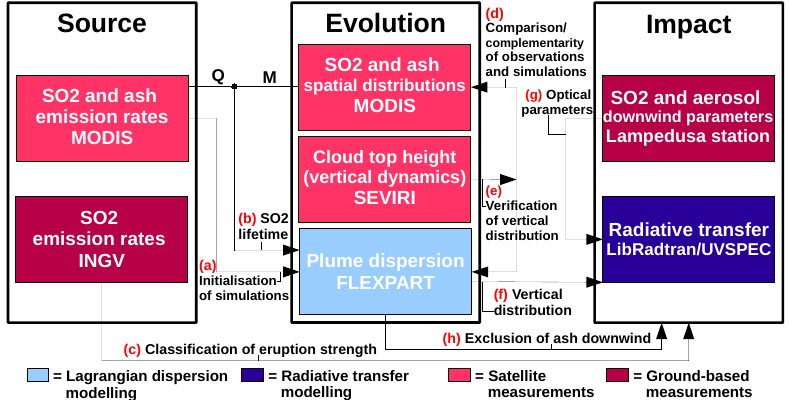
Figure 1. Scheme of the synergies of the different methods described in Sects. 2.2.1–2.4. From (a) to (h) the different synergies and contributions of the methods are indicated as they are referenced throughout the text. The symbols M and Q refer to the SO 2 mass loading and the SO 2 emission rate of Eq.